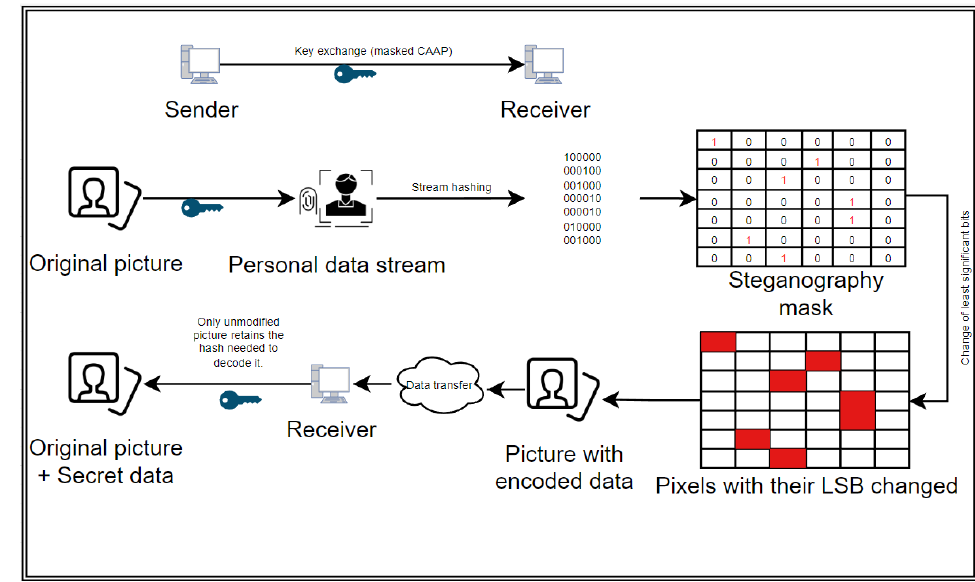
Figure 4. Secret message/watermark encoded with personal data.